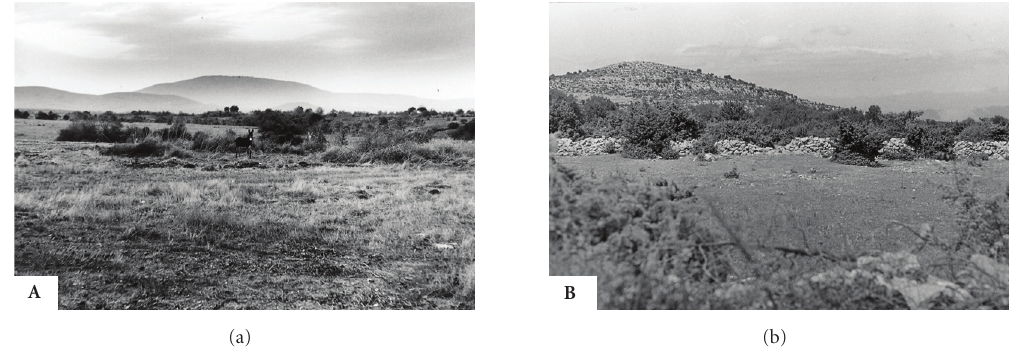
Figure 4: Natural focus of Bhanja virus infections in southeastern Bulgaria (Akhtopol, A ) and Croatia (island of Braˇc, B ).